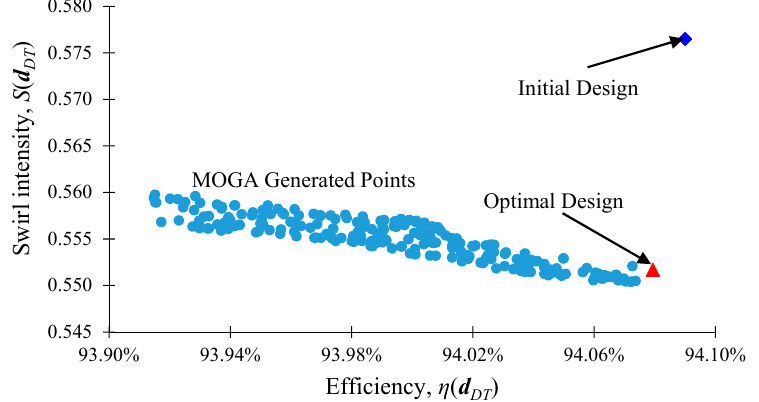
Figure 10. Pareto front for optimization of draft tube design at the design point.